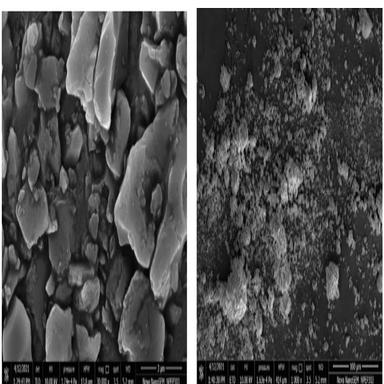
SEM analysis of PCM.